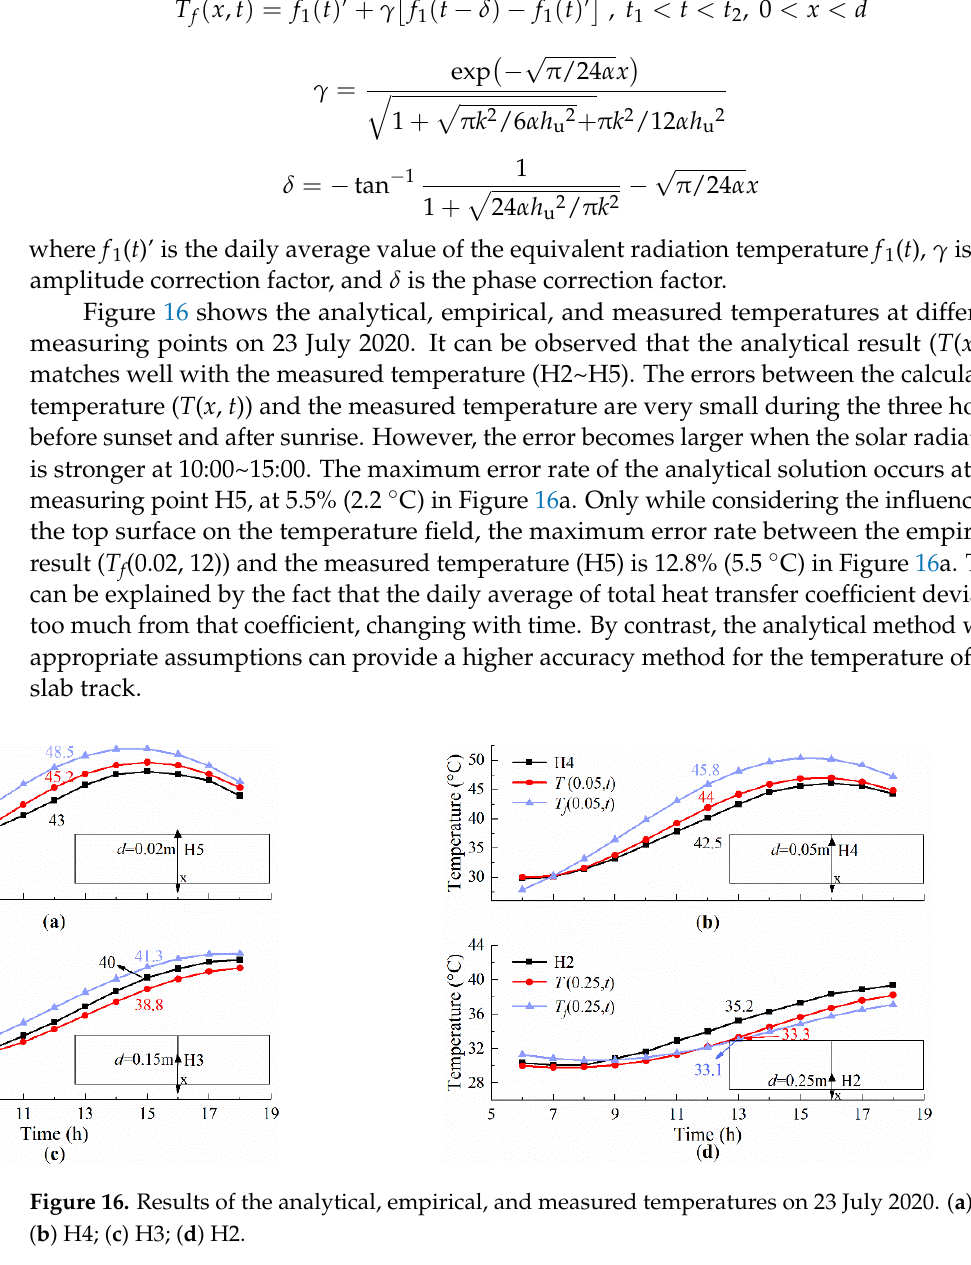
Figure 17. Time history curves of temperature components. In the solar radiation duration, the change trend of the surface temperature T is consistent with that of the component T BC1 . When time is t = 14, the calculated temperature of the top surface is 48.2 °C. Then, by substituting the temperature value into Equations (29) and (25), the instantaneous net heat flux at the top surface is 253 W·m − 2 , and the increment of the top surface temperature contributed by the component T BC1 is 17.3 °C, as